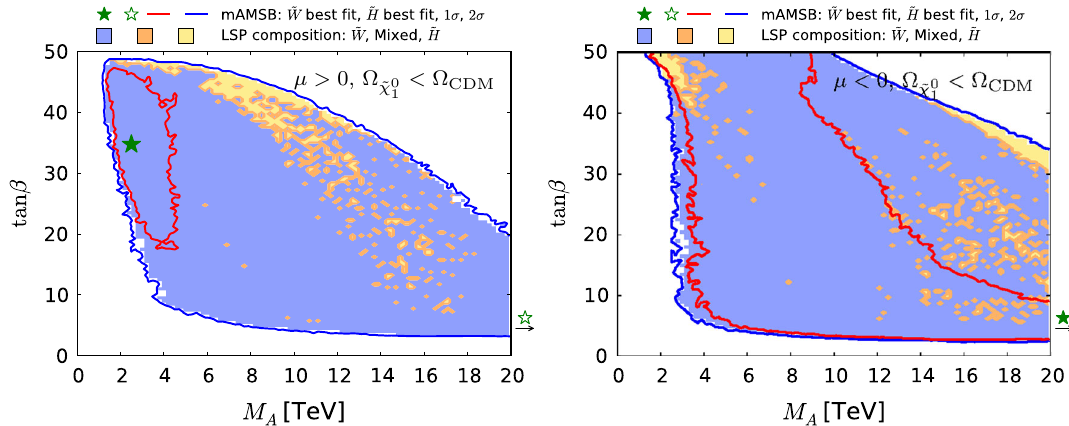
to contribute only part of the CDM density. 1